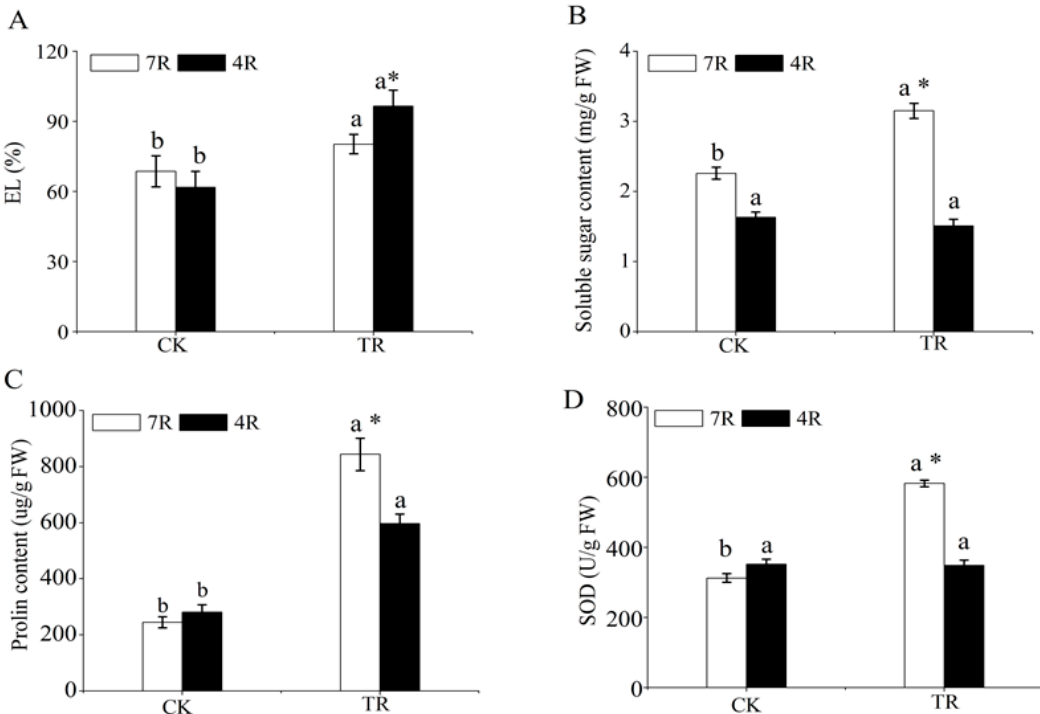
Figure 1. Responses of physiological parameters under freezing stress. ( A ) Variations in electrolyte leakage. ( B ) Soluble sugar content. ( C ) Proline content. ( D ) Superoxide dismutase (SOD) activity. Control (CK) refers to the control treatment at 20 °C; TR represents the freezing treatment at − 4 °C; 7R and 4R represent the winter turnip rape varieties, Longyou 7 and Tianyou 4, respectively; the mean and SD were calculated from three repeats of each treatment; the bars indicate the standard deviation; the columns marked with different letters (a and b) indicate significant statistical differences among the CK and TR of two varieties based on Ducan’s multiple range tests (* p < 0.05). The column marked with an asterisk indicates the significant difference in treatment (TR) of two varieties based on an independent-samples t -test (* p < 0.05).